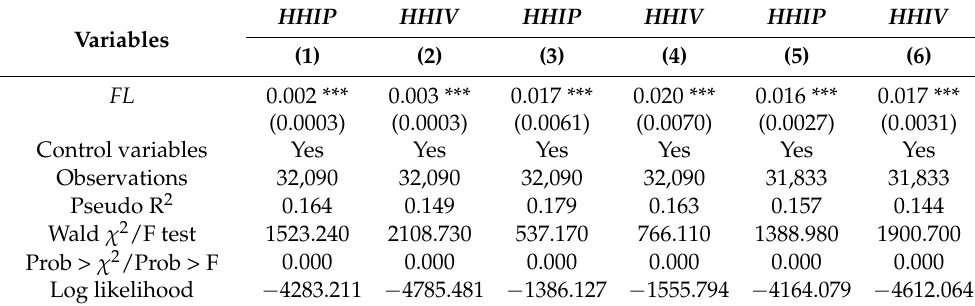
Table 9. Robustness test.